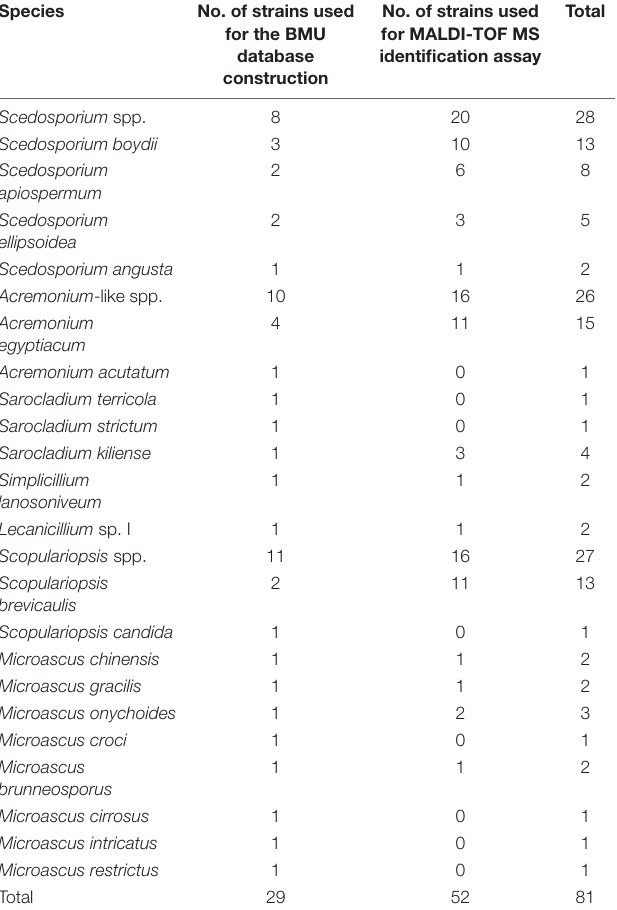
TABLE 1 | Clinical isolates and species used in this study for Beijing Medical University (BMU) database construction and matrix-assisted laser desorption ionization-time of flight mass spectrometry (MALDI-TOF MS) identification assay. Species